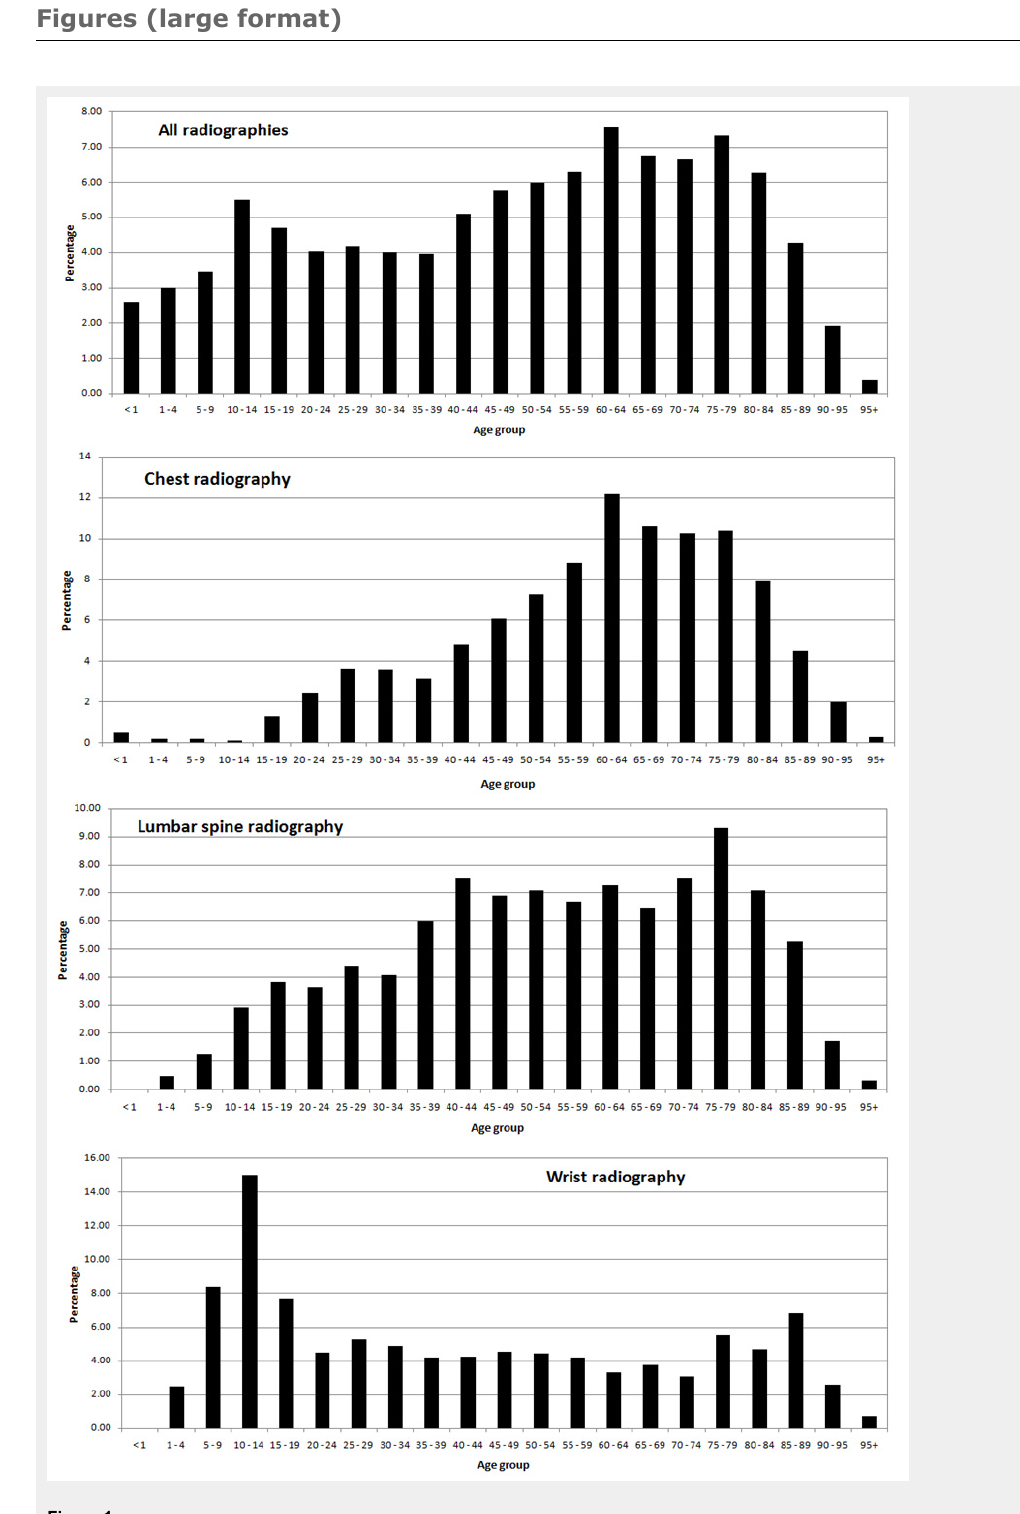
Figure 1: Patient age distributions for all radiological examinations and specific for chest, lumbar spine and wrist, extracted from the 2008 data of